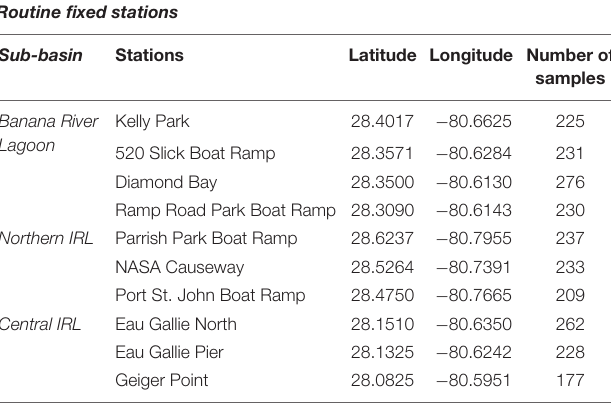
TABLE 1 | The geographic coordinates of the 10 routine fixed stations monitored in the different sub-basins of the IRL are shown along with the total number of samples collected at